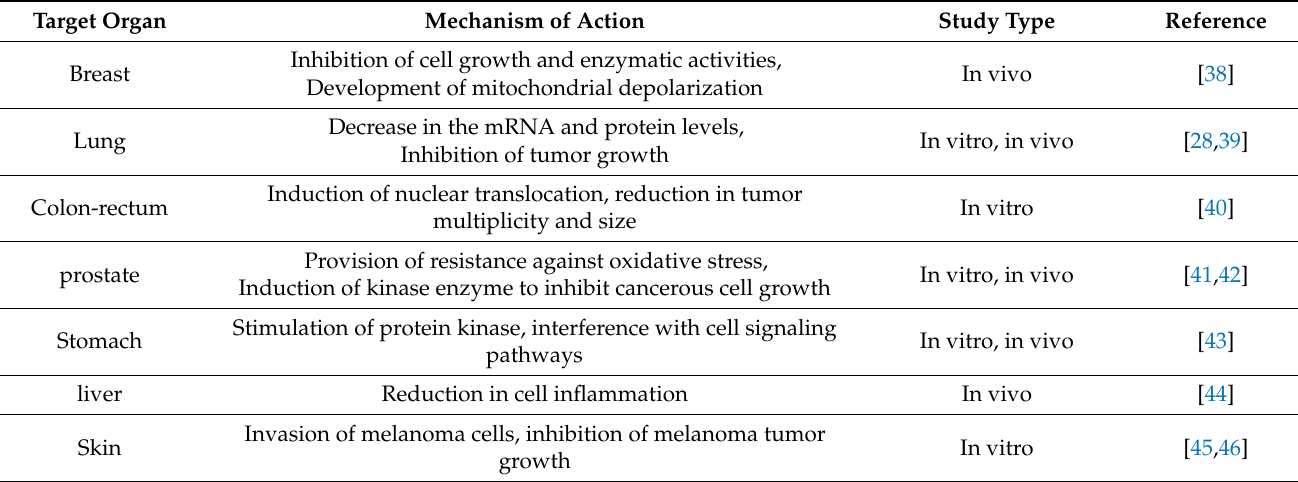
Table 2. Effects of green tea polyphenols in preventing